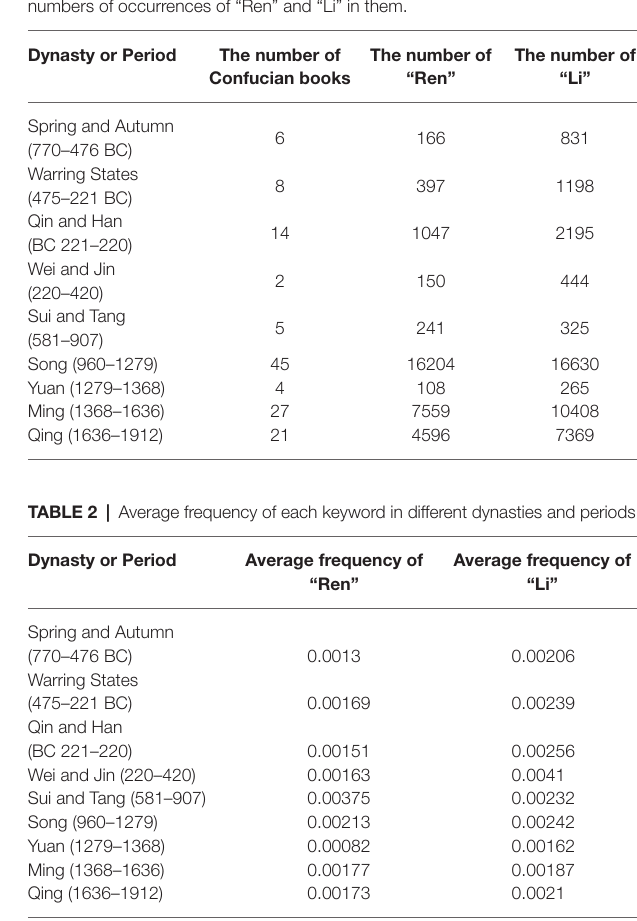
TABLE 1 | The number of Confucian books by dynasty or period and the numbers of occurrences of “Ren” and “Li” in them.